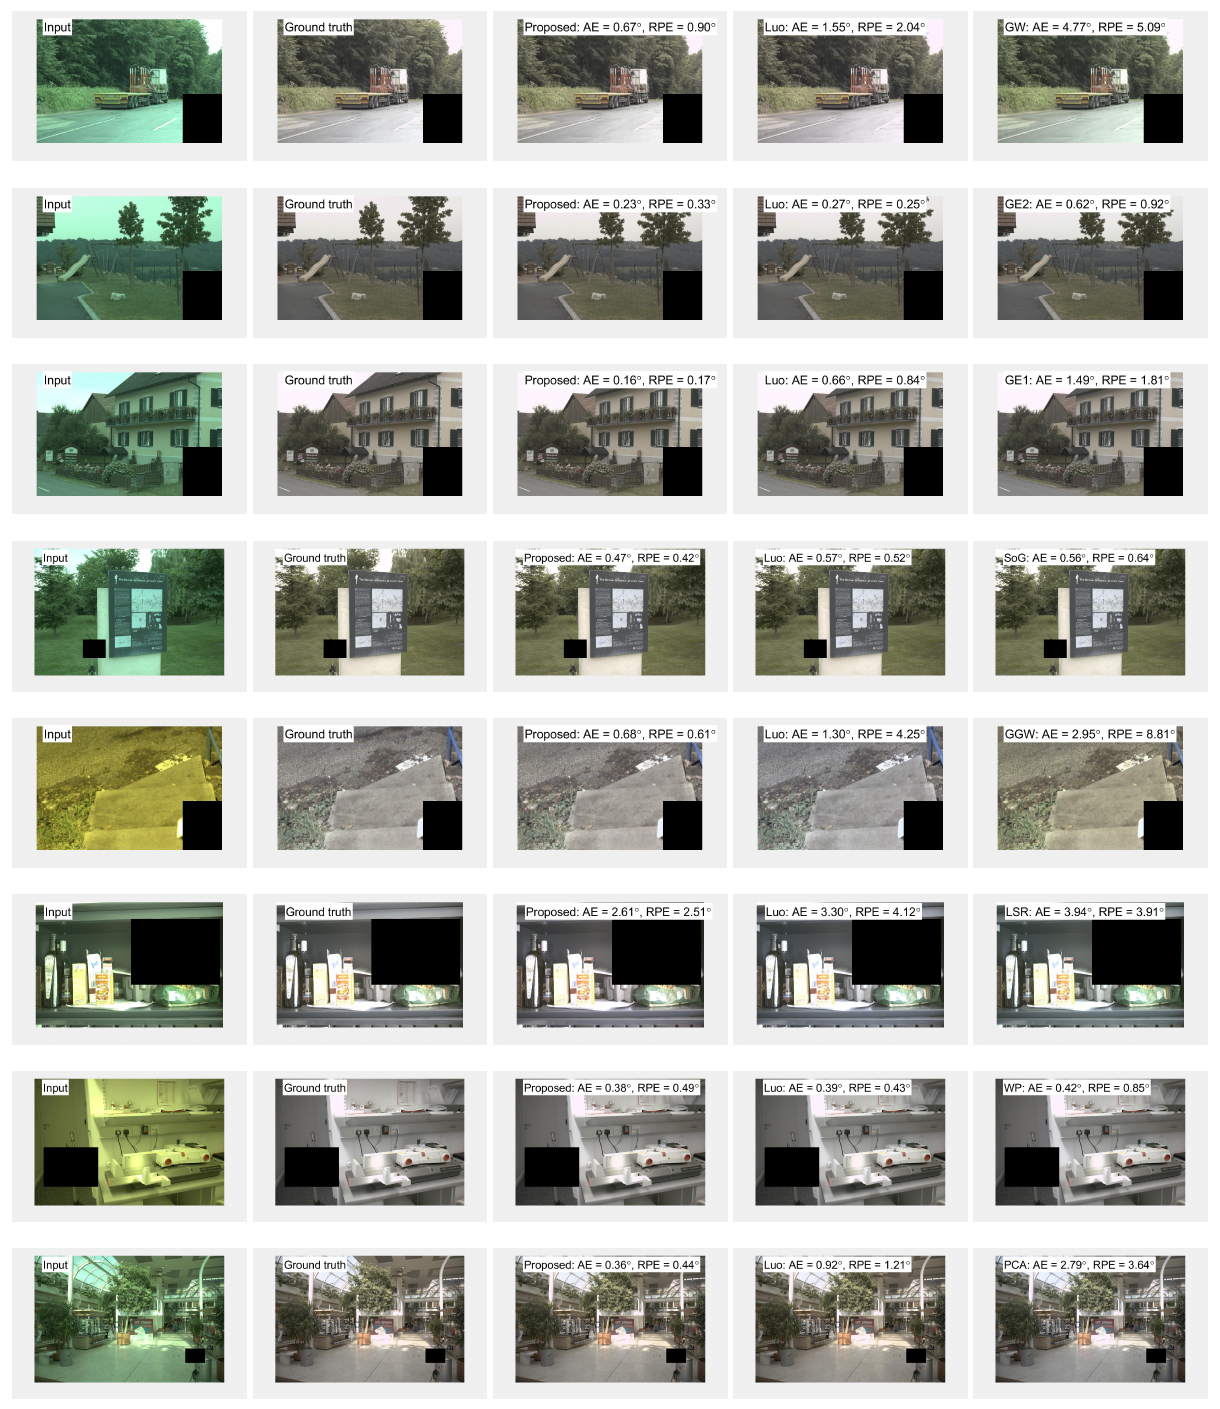
Figure 3. Comparison among the proposed, Luo’s [19], and conventional methods. The test images are from the Gehler-Shi and Cube+ datasets, and the resulting images are shown here by column corresponding to: ( 1 ) input images; ( 2 ) ground truths; ( 3 ) the proposed; ( 4 ) Luo’s, and ( 5 ) conventional methods (GW, WP, GE1, GE2, SOG, PCA-based, GGW, or LSR), respectively. These images include some common lighting scenes such as outdoor natural, outdoor artificial lighting, indoor artificial lighting, indoor natural lighting, combined natural and artificial lighting, etc. For each corrected image, the recovery AE (AE, for short) and the reproduction AE (RPE, for short) are displayed at the top, respectively. It should be noticed that these images displayed here are rendered just with some preliminary post-processing in the sRGB color